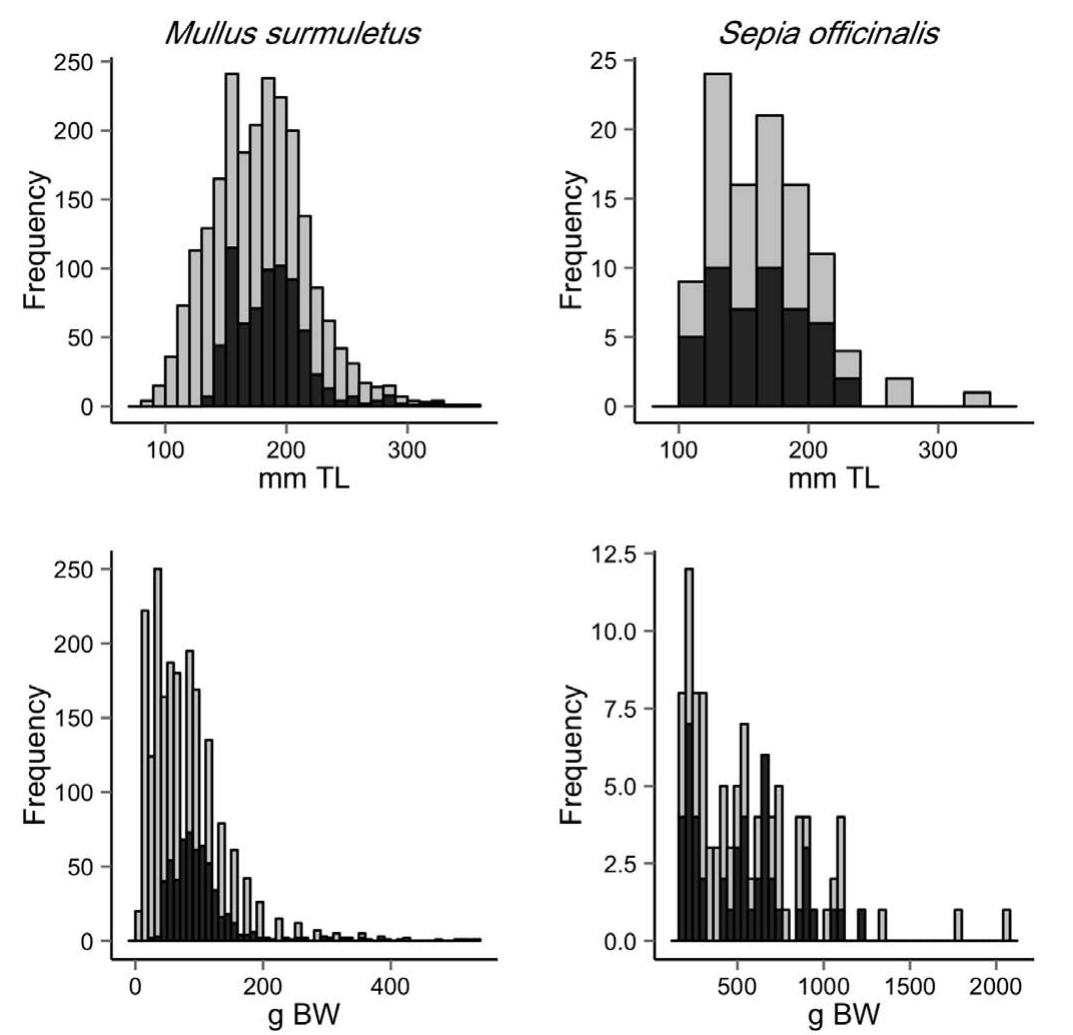
Fig. 2. – Size frequency (top) and body weight frequency (bottom) of striped red mullet ( Mullus surmuletus , left) and cuttlefish ( Sepia of- ficinalis , right) in Vilanova i la Geltrú during the period 2000-2013, based on 12 month on-board sampling in 2009-2010. Grey bars: bottom trawl, black bars: trammel